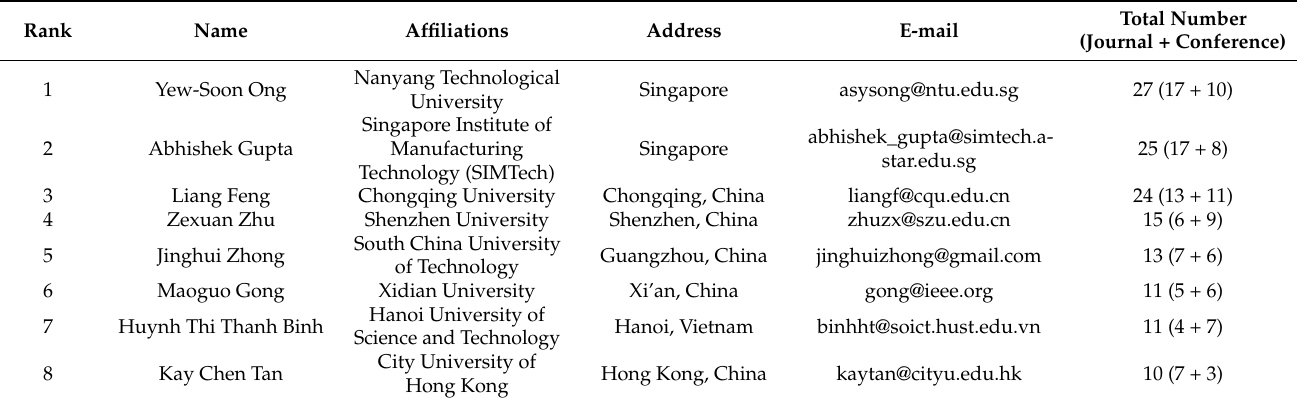
Table 2. The most prolific contributing authors devoted to MTO and